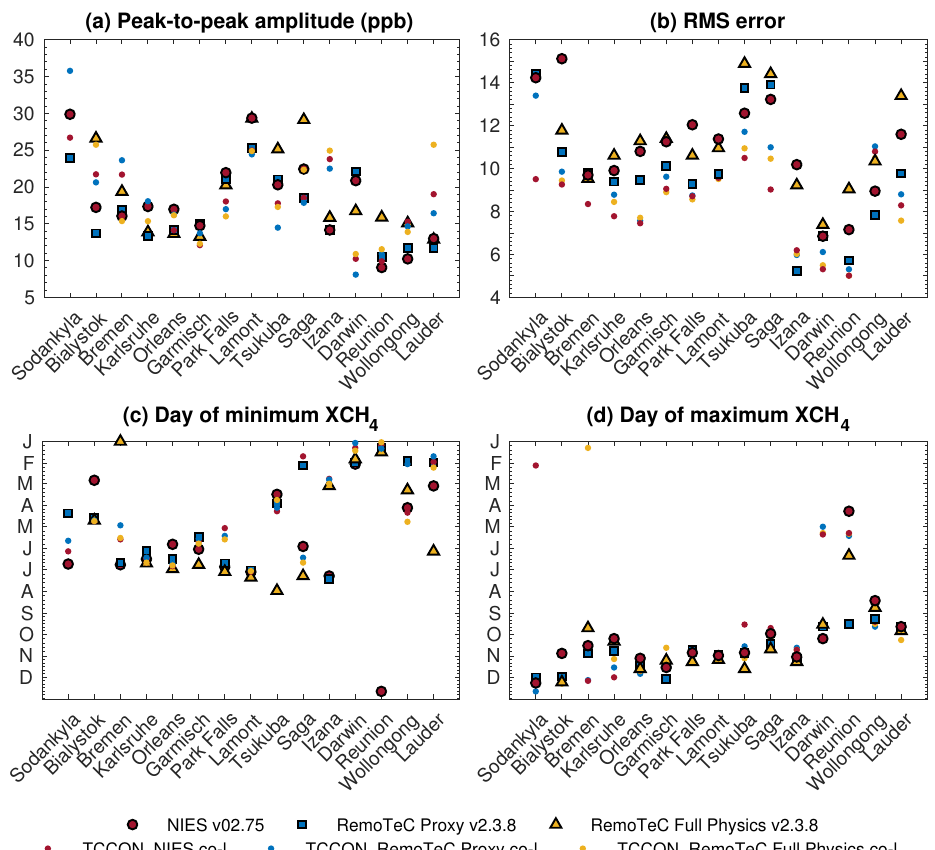
Figure 8. Comparison of GOSAT XCH 4 retrievals and co-located TCCON retrievals at 11 sites in the Northern Hemisphere and four sites in the Southern Hemisphere. The studied parameters are: ( a ) peak-to-peak amplitude, ( b ) root-mean-square (RMS) error, ( c ) day of minimum XCH 4 and ( d ) day of maximum XCH 4 . The northernmost site is in each panel on the left and the southernmost site is on the